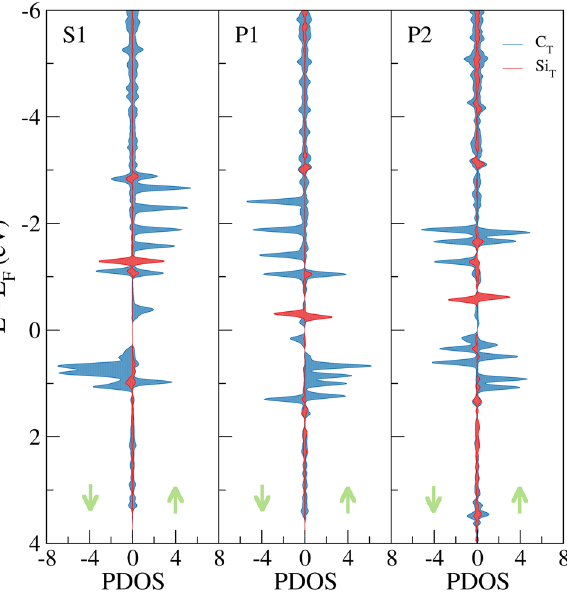
Figure 3. Projected density of states (PDOS) of the S1 , P1 and P2 ground state structures. Positive and negative values correspond to α and β channels, respectively. Only the density of the top edge atoms is shown. The Fermi energy ( E F ) is set to zero in all